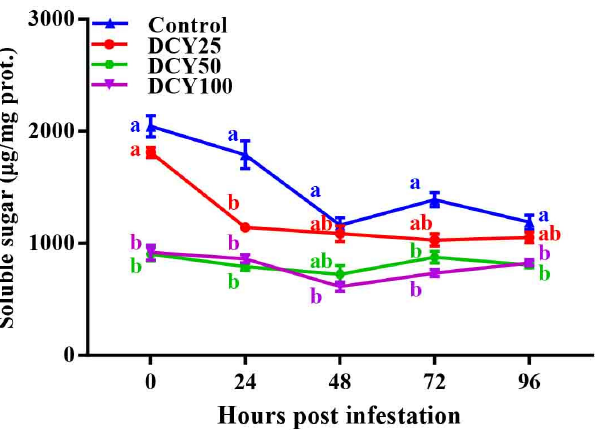
Figure 5. Concentrations of soluble sugar content in rice leaf sheaths in response to DCY treatment and SBPH infestation. Data represent means ± standard error of three replicates. Significant difference between DCY and Control plants is indicated by letters (a,b) ( p < 0.05, Tukey’s HSD test).